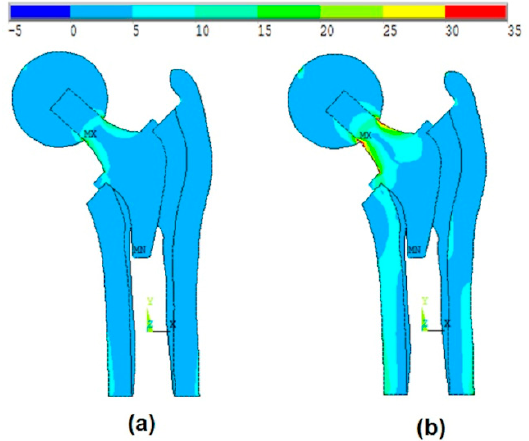
Figure 12. The effect of the introduction of the ball, bone anisotropy, and the stem shape optimization on the von-Mises stress distribution at ( a ) the optimal point and ( b ) the failure point.